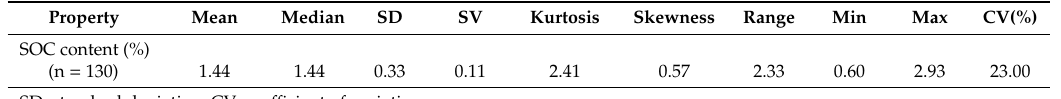
Table 1. Descriptive statistics of the soil’s soil organic carbon (SOC) contents in the study area.